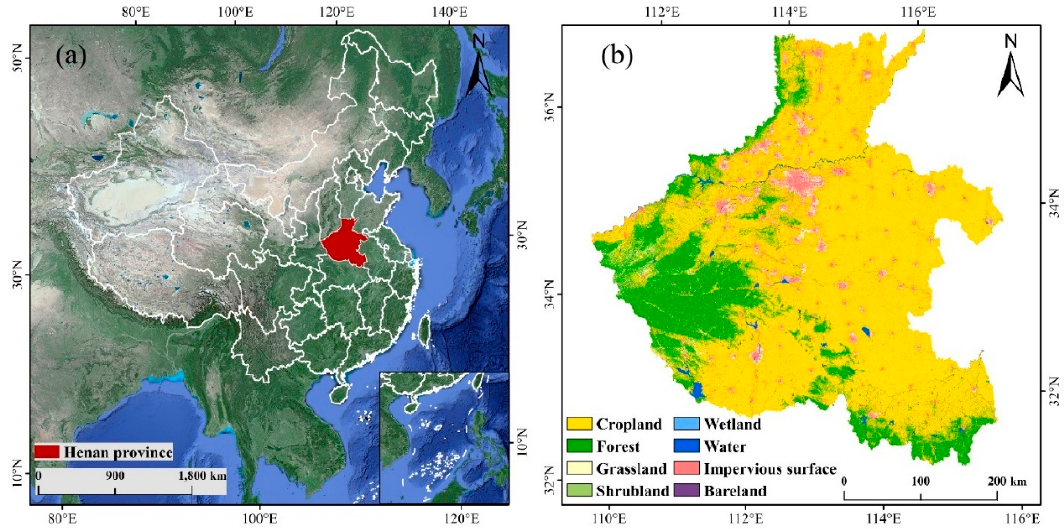
Figure 1. ( a ) Location and ( b ) Spatial pattern of the land type of Henan Province, PRC.